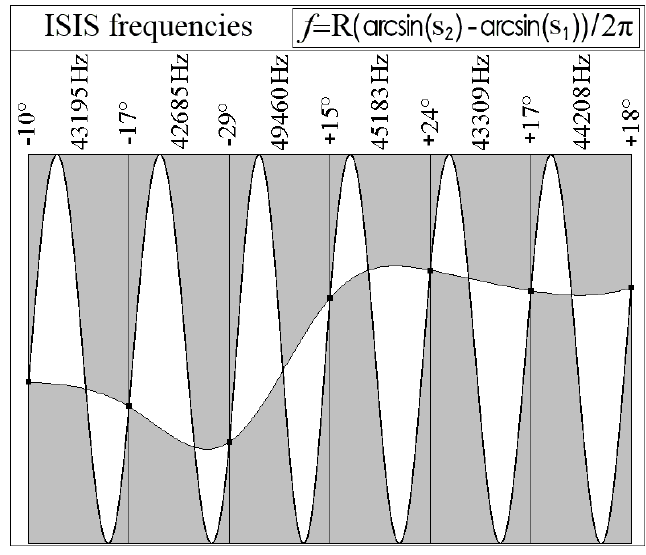
Figure 18: Formula for ISIS-analysis of a sound wave with a graphic